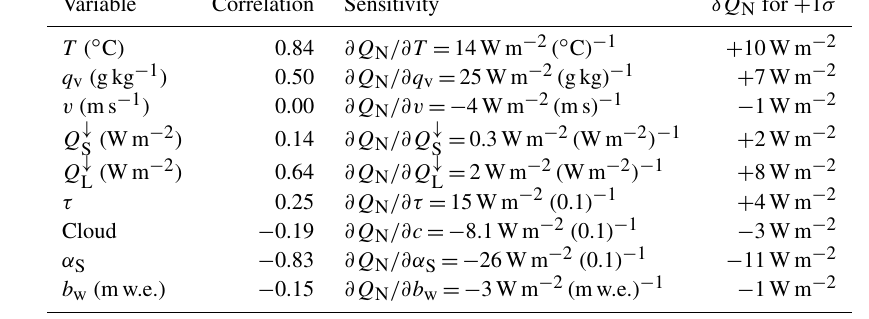
Table 6. Correlation and sensitivity of different weather variables to the mean summer (JJA) net energy flux, Q N , for the NARR simulations, 1979–2014. “Cloud” is the NARR total cloud fraction.